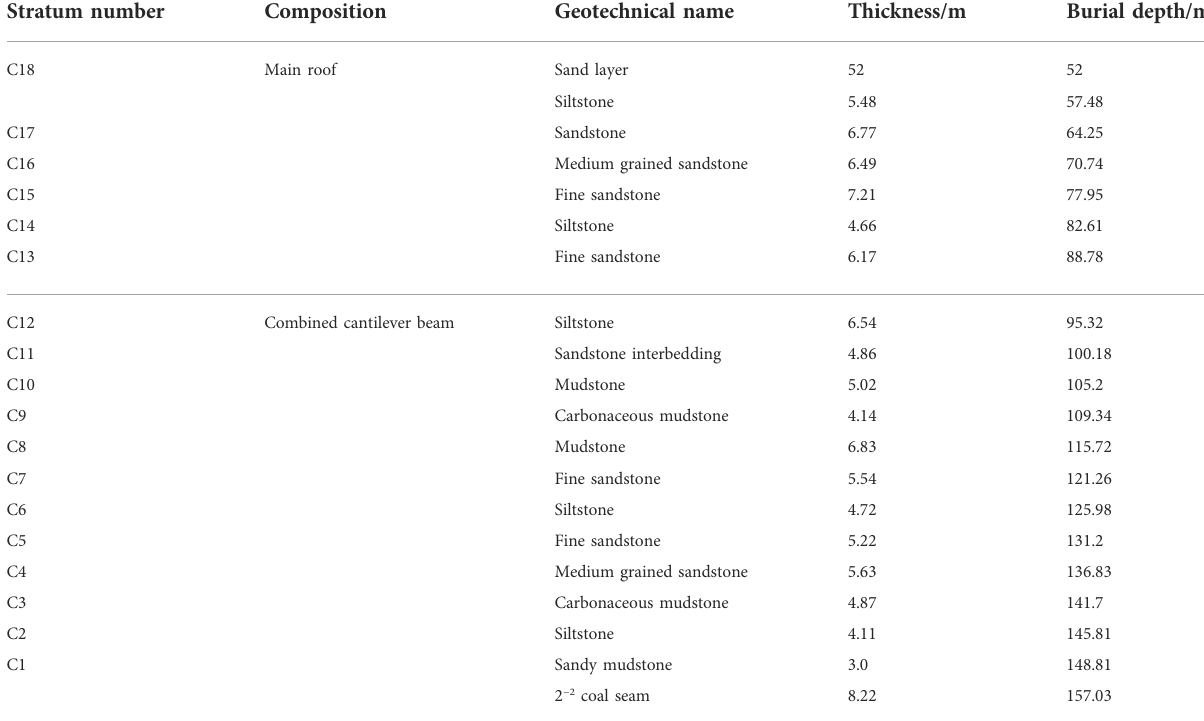
TABLE 5 Lithology of the no.60 support in 31,206 working face. Stratum number